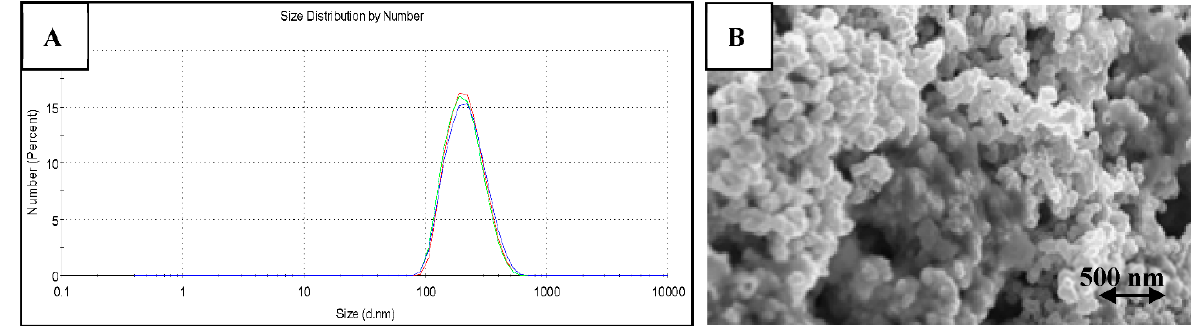
Figure 3. The size distribution ( A ), as the value of three subsequent runs of the instrument, and SEM image ( B ) of Ni-Ag NPs.